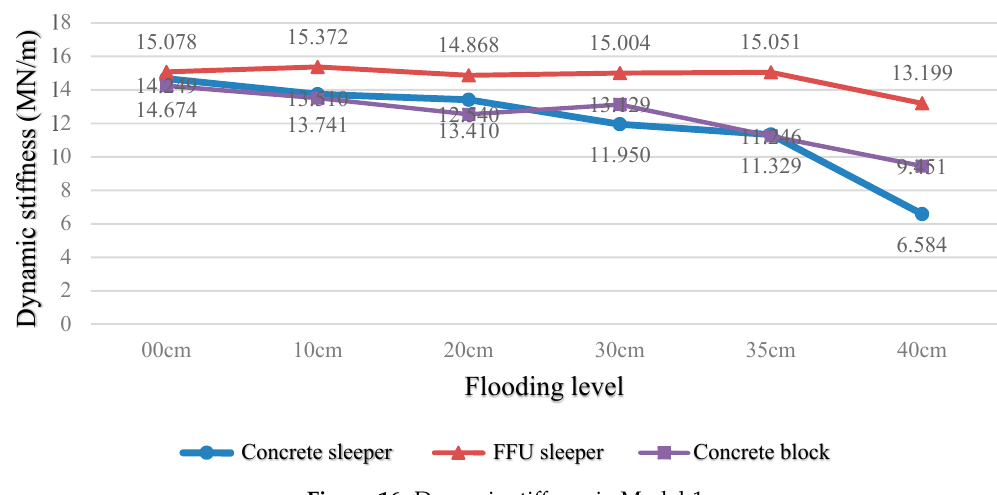
Figure 16. Dynamic stiffness in Model-1.